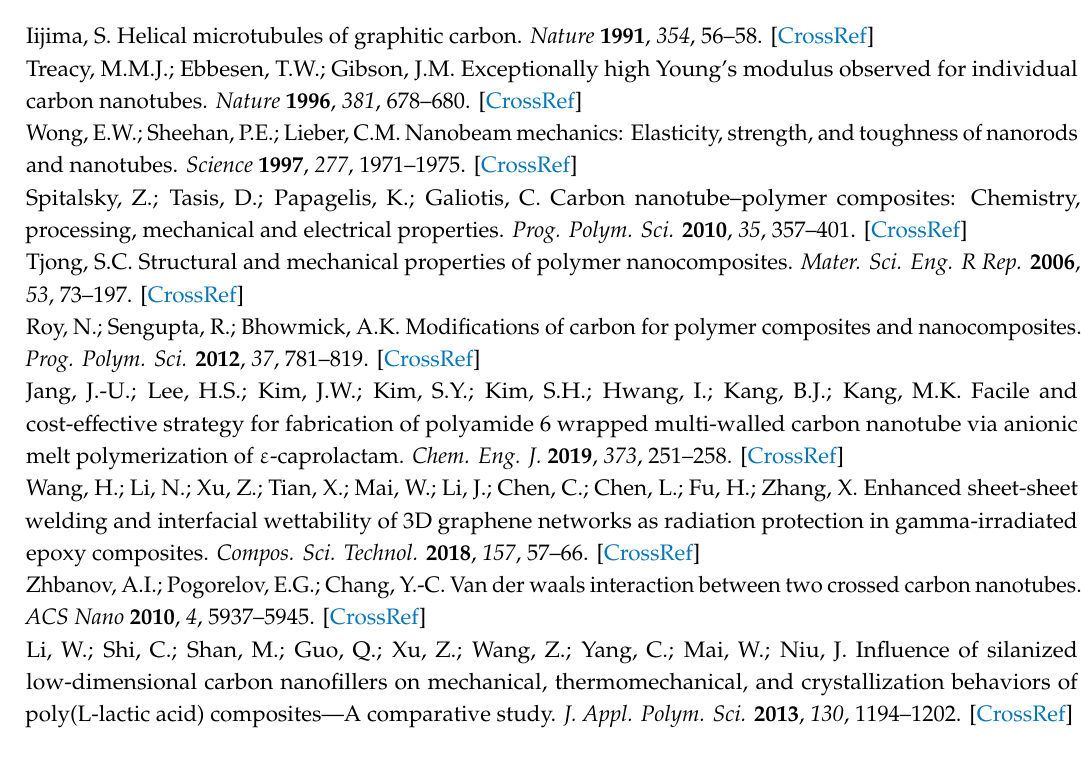
Figure S1: Anionic polymerization of ε -caprolactam, Figure S2: Screw configuration and barrel